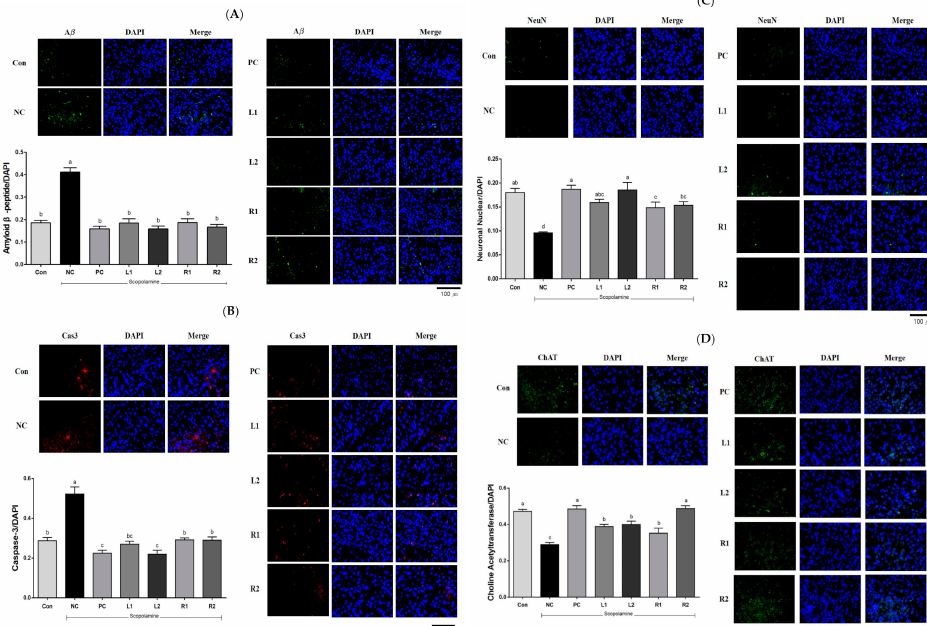
Figure 7. Effects of AH leaf and root extracts on protein expression by immunofluorescences staining in the hippocampus of C57BL/6 mice with scopolamine-induced memory impairment. ( A ) Amyloid β -peptide/DAPI, ( B ) Caspase-3/DAPI, ( C ) Neuronal nuclear protein/DAPI, and ( D ) Choline Acetyl- transferase/DAPI. All values are expressed as the mean ± SEM. a–d Differences were considered statistically significant at p <